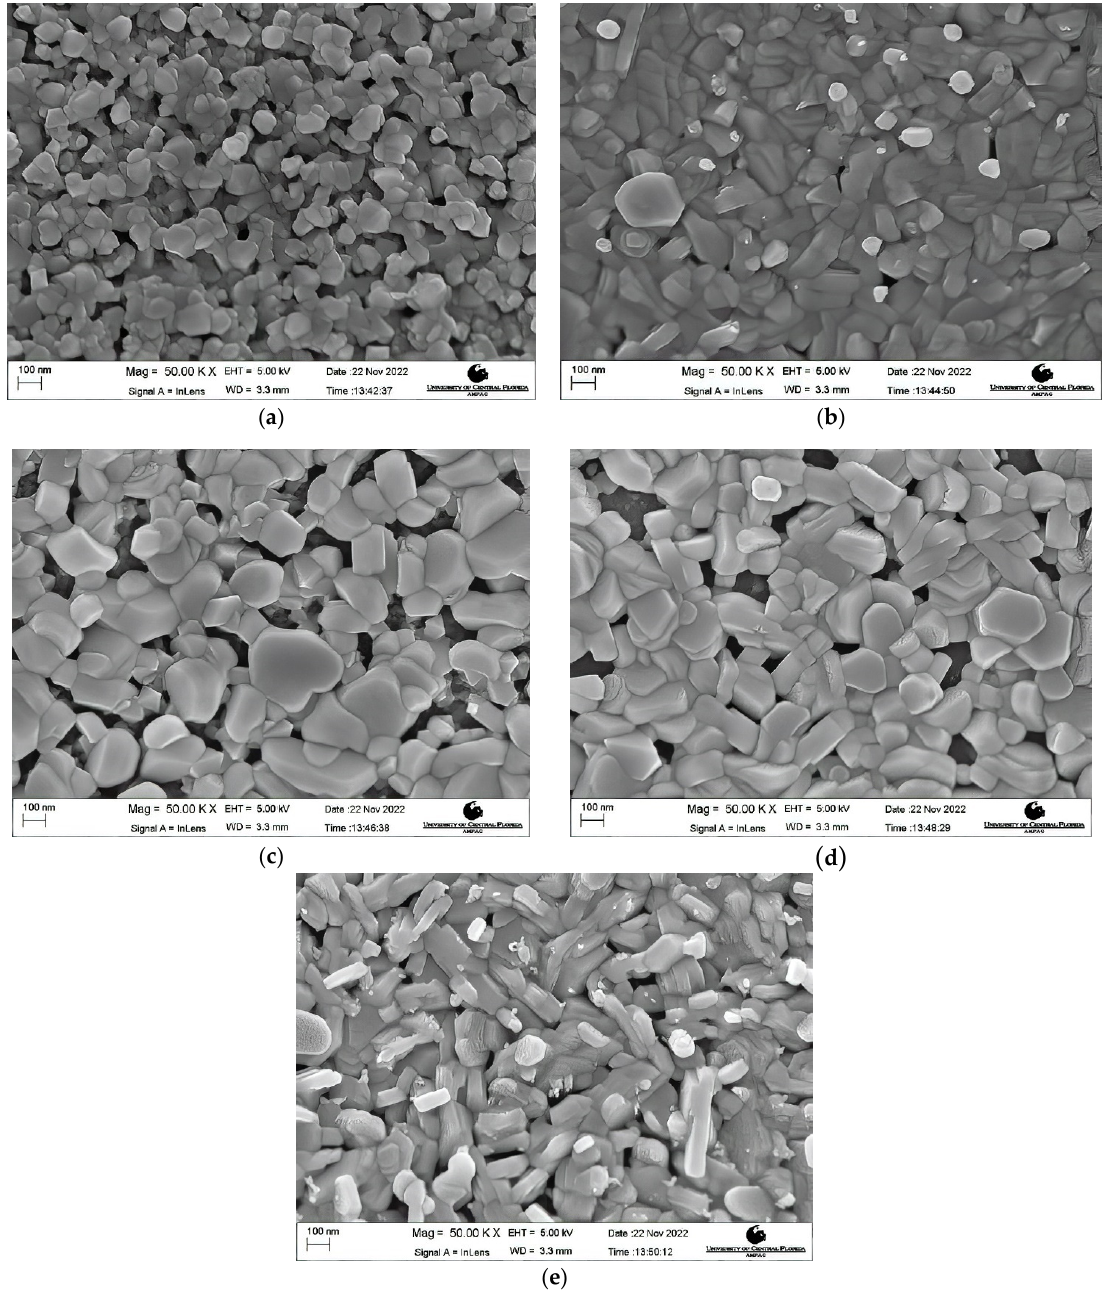
Figure 4. FESEM images of the films annealed at ( a ) 600 °C, ( b ) 650 °C, ( c ) 750 °C, ( d ) 800 °C, and ( e ) 900 °C.